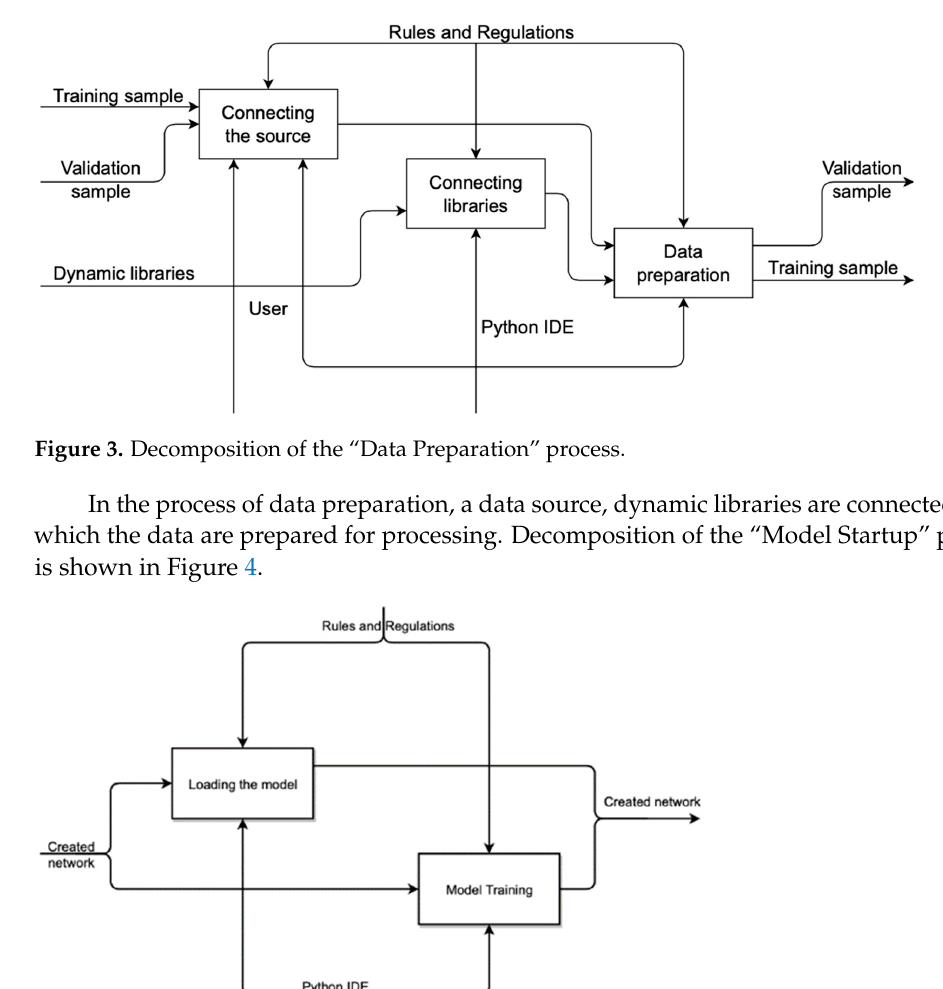
Figure 4. Decomposition of the “Model Startup” process.